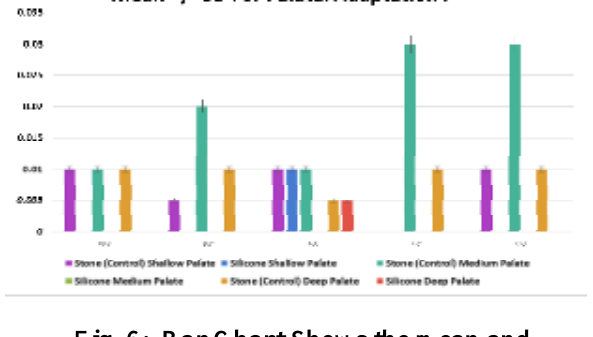
Fig. 7: Bar Chart Shows the mean and standard deviations for both teeth movements when acrylic resin processed by fast autoclave cycle.